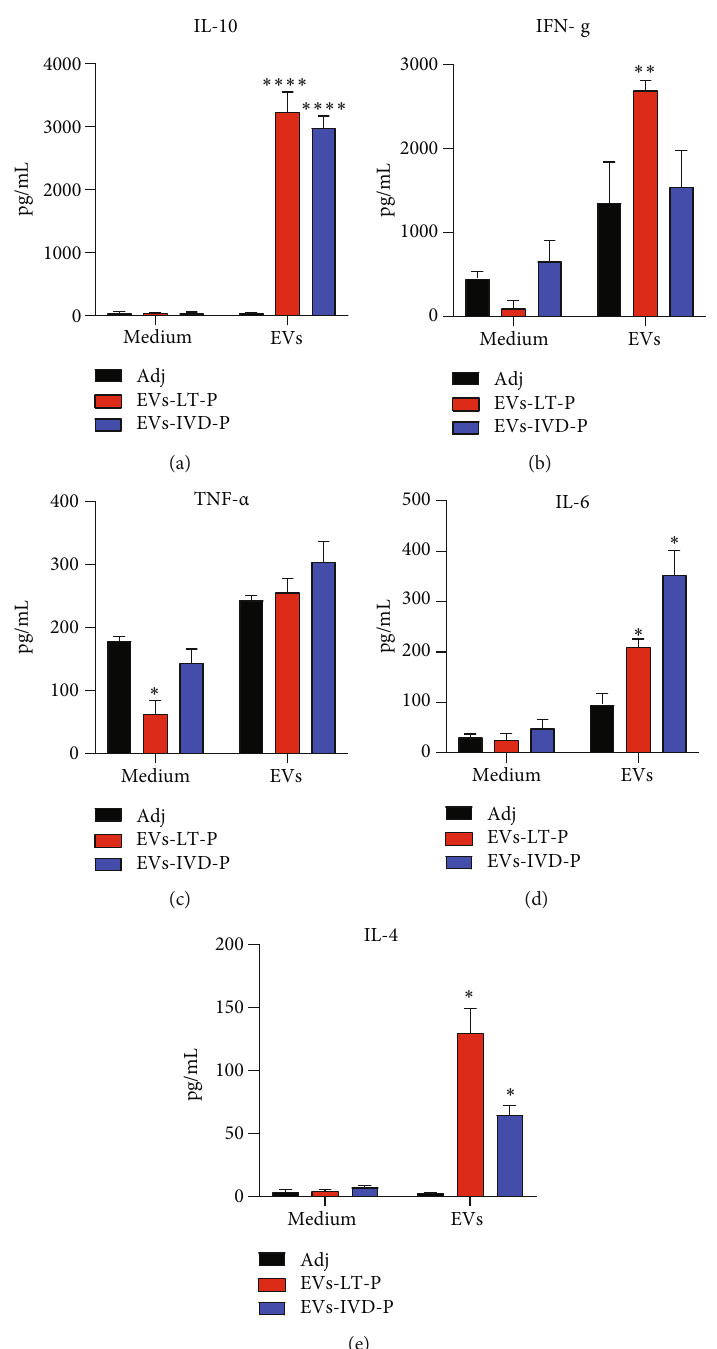
Figure 8: Cytokine responses in mice immunized with EVs from LT-P and IVD-P. BALB/c mice ( n = 5 per group) were immunized with EVs LT-P and EVs IVD-P mixed with adjuvant. Controls received adjuvant alone (Adj). Two weeks after the last dose, spleen cells were collected and cultured with medium alone (medium) or stimulated with each homologous EVs used for immunization (EVs). (a) Measurement of IL-10, (b) IFN- γ , (c) TNF- α , (d) IL-6, and (e) IL-4 cytokine levels in cell supernatants. The bars indicate that the mean and the error bars denote the standard deviation of the groups. Statistics were performed using two-way ANOVA, followed by the Tukey post test. ∗ indicates signi fi cant di ff erence in relation to the groups of mice immunized with EVs and adjuvant alone ð ∗ P < 0 : 05, ∗∗ P < 0 : 01, and ∗∗∗∗ P < 0 : 0001 Þ